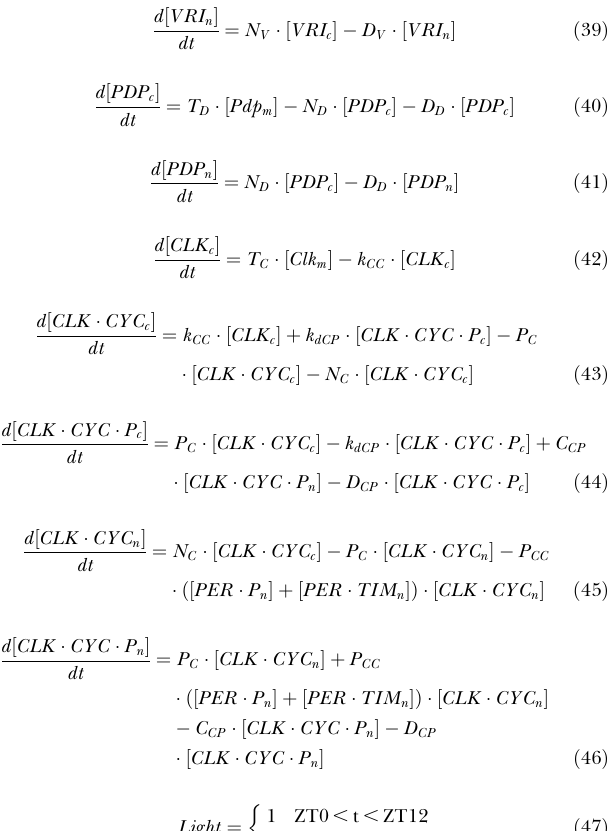
Figure S1. The Translation or Degradation of clk Protein Balance To Produce a Nearly Constant Level of Total CLK The reaction rate shown is normalized by the maximum level of total CLK. The degradation term includes both cytoplasmic and nuclear degradation (as defined in Equations 44 and 46). Found at doi:10.1371/journal.pcbi.0030154.sg001 (7.3 MB TIF). Figure S2. The Evolution of the dbt P / dbt ar Mutants away from a Point on the Wild-Type Constant Darkness Limit Cycle Found at doi:10.1371/journal.pcbi.0030154.sg002 (319 KB TIF). Protocol S1. SBML Representation of the Isolated Mass Action Model Found at doi:10.1371/journal.pcbi.0030154.sd001 (7 KB TXT). Protocol S2. SBML Representation of the Isolated Serial Model for N ¼ 100 Found at doi:10.1371/journal.pcbi.0030154.sd002 (111 KB TXT). Protocol S3. SBML Representation of the Isolated Positive Feedback Model Found at doi:10.1371/journal.pcbi.0030154.sd003 (10 KB TXT). Protocol S4. SBML Representation of the Detailed Circadian Rhythms Model Found at doi:10.1371/journal.pcbi.0030154.sd004 (51 KB TXT). Table S1. Isolated Model Parameters Table S2. Full Circadian Model Parameters Table S3. Parameter Changes to Describe Mutant Phenotypes Found at doi:10.1371/journal.pcbi.0030154.st003 (28 KB DOC). Table S4. Experimental mRNA and Protein Measurement Sources Found at doi:10.1371/journal.pcbi.0030154.st004 (31 KB